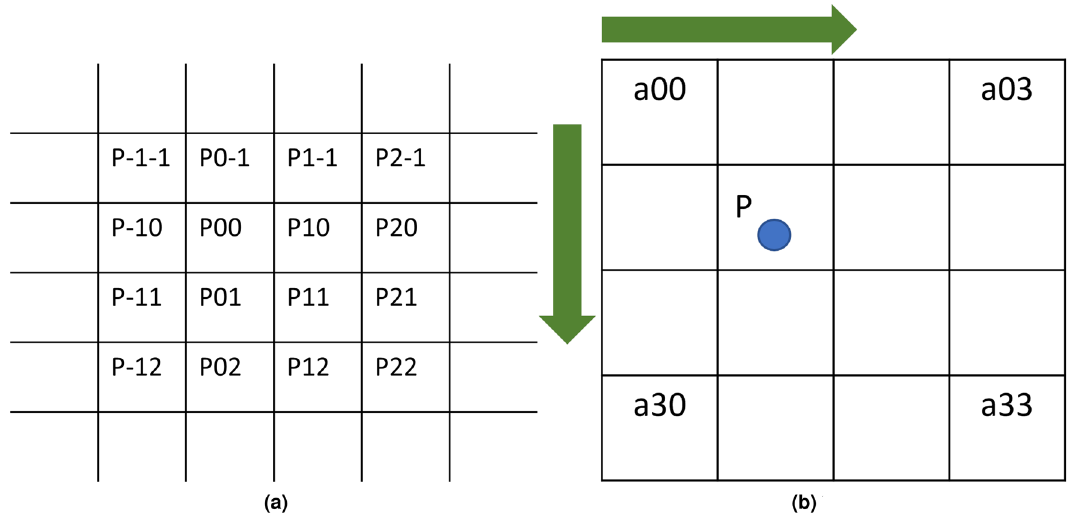
Figure 3. Representation of 16 nearest pixels. ( a ) Representation of 16 nearest Pixel. ( b ) This figure is the illustration of point P on the target feature